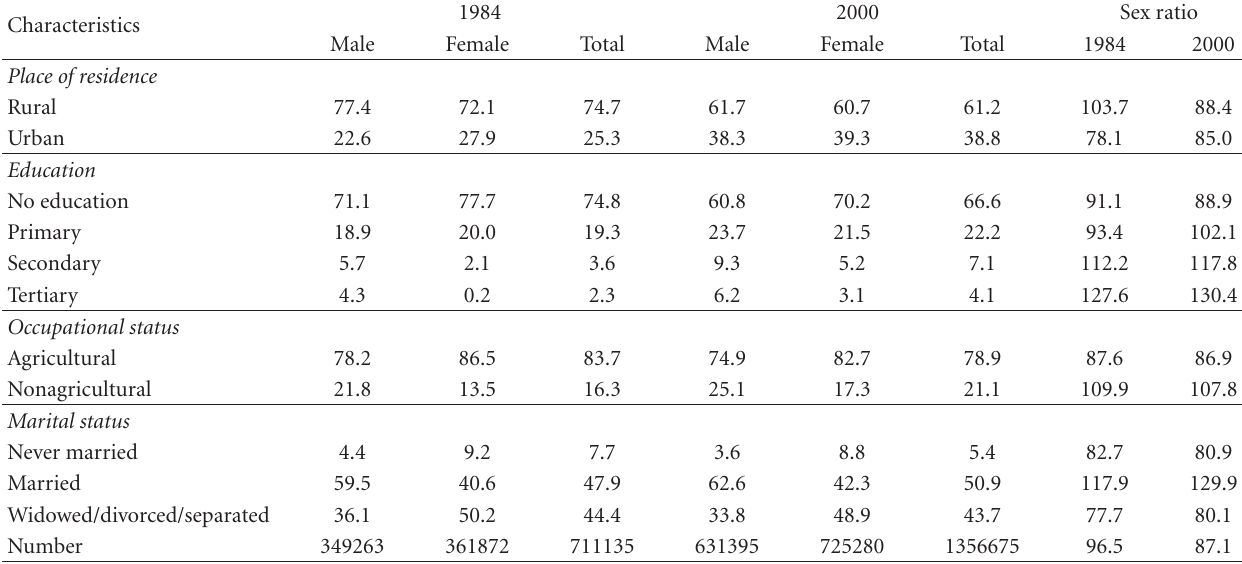
Table 4: Percentage distribution of elderly persons aged 60 and above in Ghana by selected characteristics, 1984–2000. Characteristics